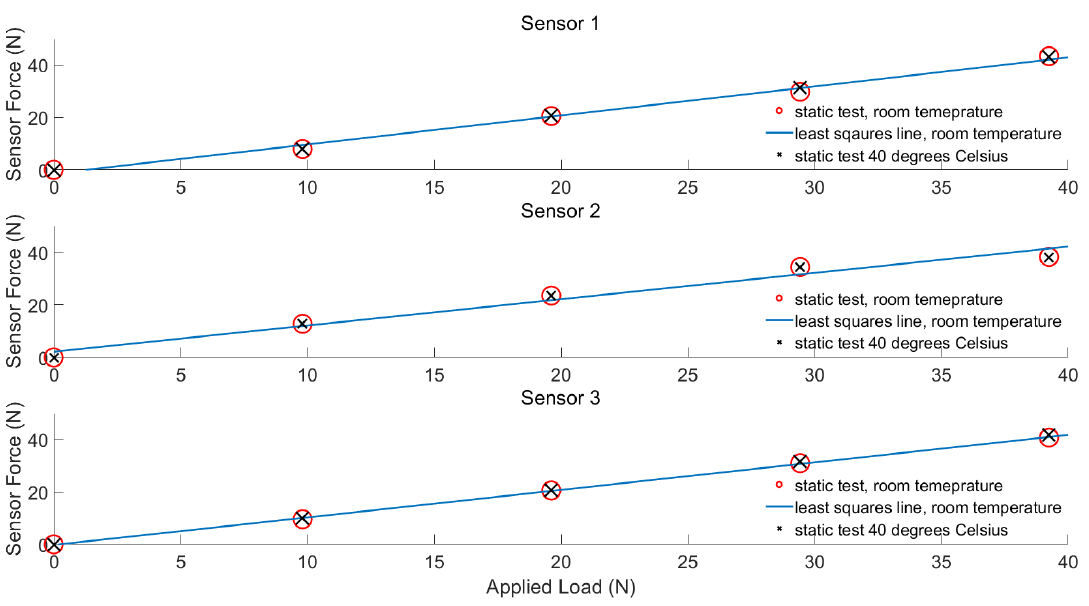
Figure 3. Static testing at room and body (40 °C) temperatures for three different SingleTact sensors. Table 1. Percentage drift over 1 min constant loading.